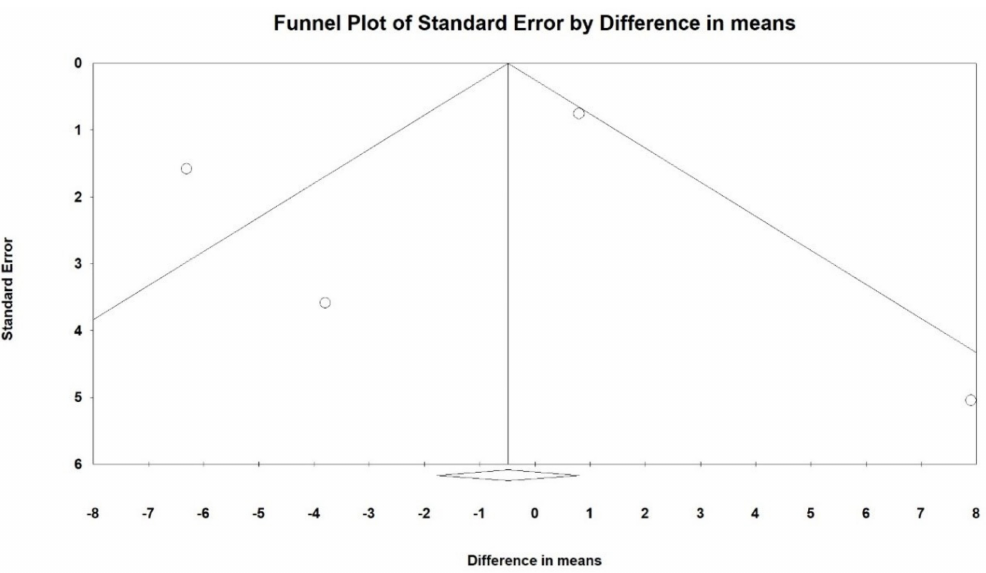
Figure 6. Funnel plot for LOS (DM) in present meta-analysis.